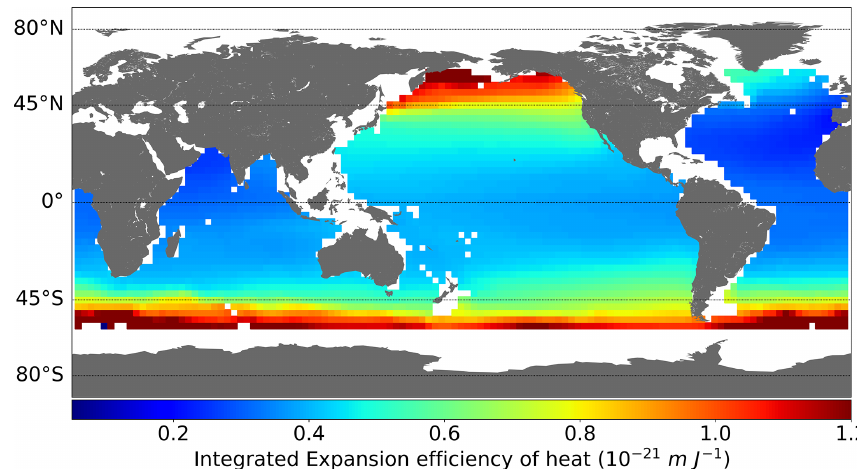
Figure 1. Integrated expansion efficiency of heat (IEEH) coefficients (mJ − 1 ) at the regional scale (3 ◦ × 3 ◦ ). See text.